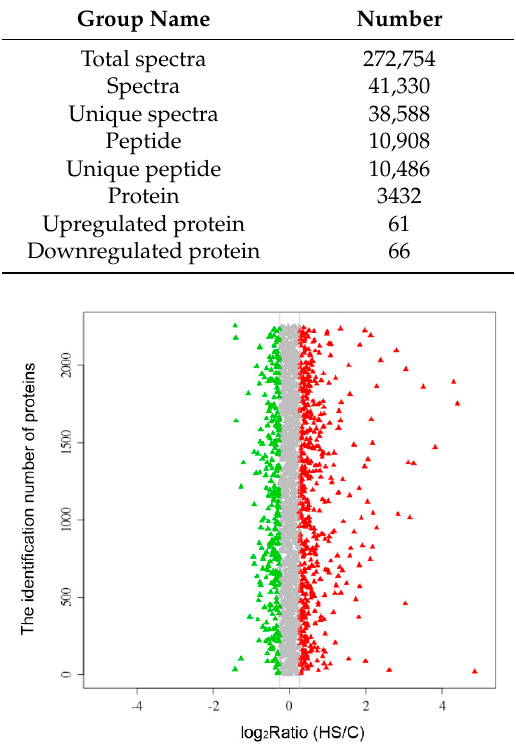
Figure 1. The change level of global proteins in the intestine in the heat shock group (HS) compared with the control group (C). Only the proteins with log 2 Ratio (HS/C) >0.26 or < − 0.26 were colored (fold changes >1.20 as red and <0.83 as green).